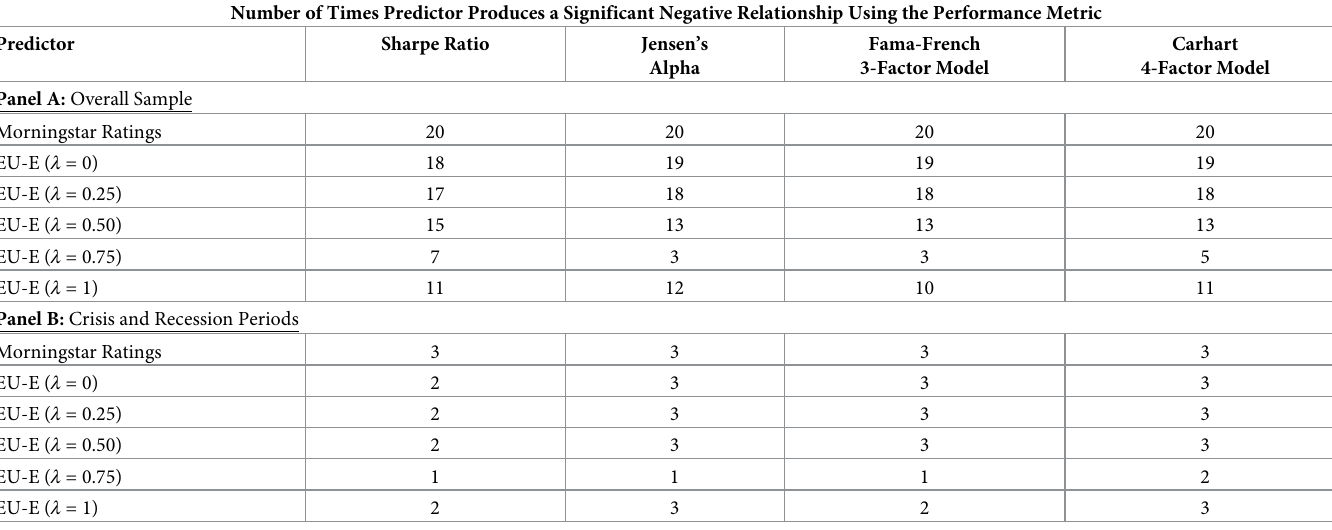
Table 9. Summary of the predictive ability of rating measures observed across performance metrics. Number of Times Predictor Produces a Significant Negative Relationship Using the Performance Metric Predictor Sharpe Ratio Jensen’s